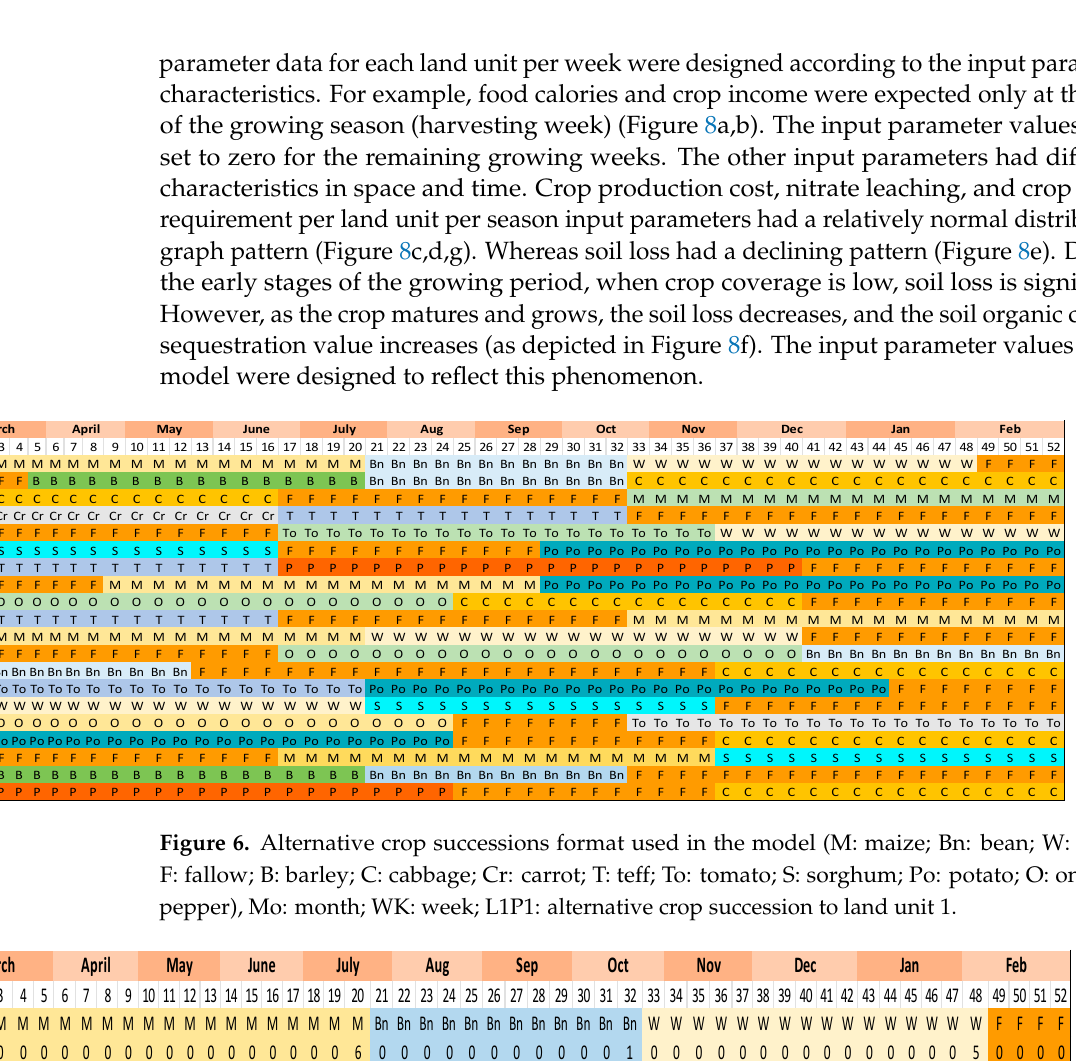
(B), green beans (Bn), cabbage (C), carrot (Cr), dry onion (o), pepper (p), potato (Po), maize (M), sorghum(S), teff (T), tomato (To), and wheat (W) that are commonly used by farmers